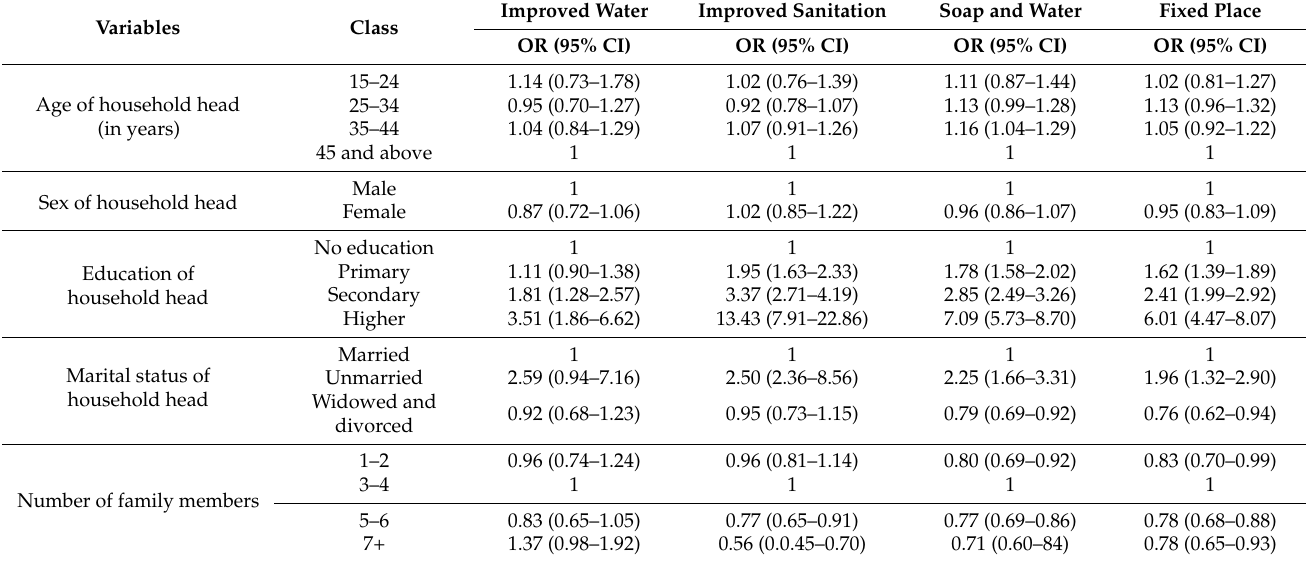
Table 3. Bivariate analysis of correlates of having access to improved water sources, improved sanitation, availability of soap and water, and access to a fixed place for handwashing. Variables